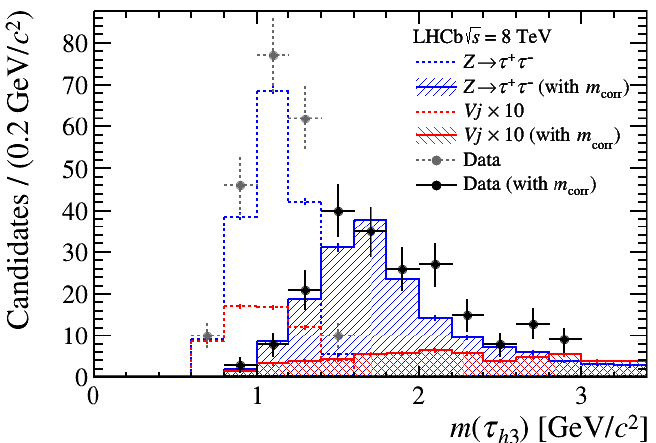
Figure 1 . Distributions of invariant (dashed line) and corrected (full line, shaded) mass of (cid:28) h 3 candidates from the (cid:28) (cid:22) (cid:28) h 3 channel. The yields are normalised to the integrated luminosity of the data. The results from data are represented by the black points. The error bars represent the statistical uncertainty only. The distributions are compared to the signal distributions from